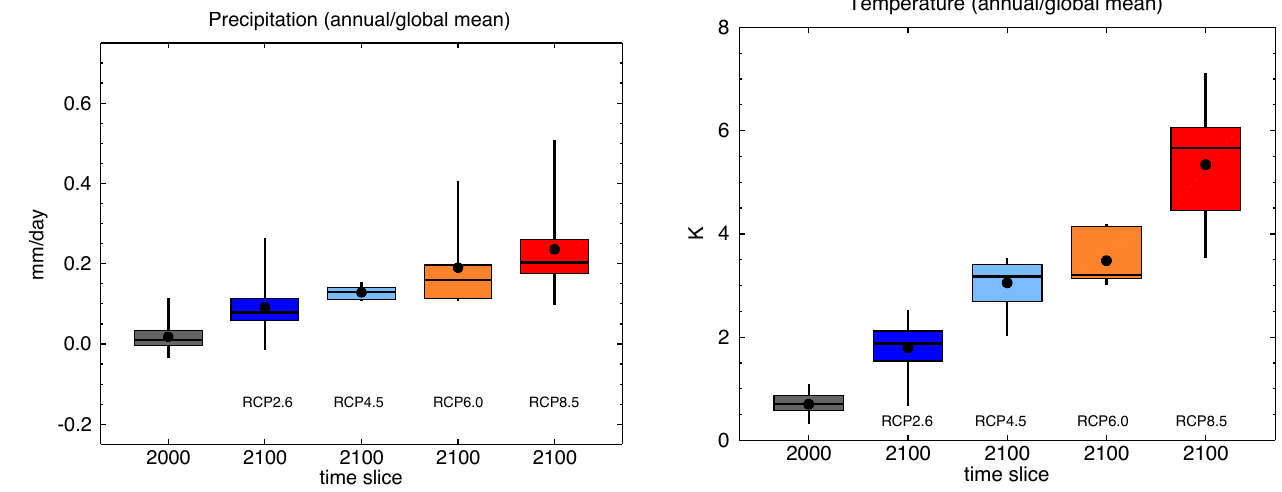
Fig. 8. Global annual mean precipitation change since 1850. The multi-model mean is indicated by the solid black dot, the median by the solid black line, the 25%–75% range by the extent of the colored box and the minimum/maximum by the extend of the whisker. Note the there is variation in the number of models between the various simulations (see Table 2).